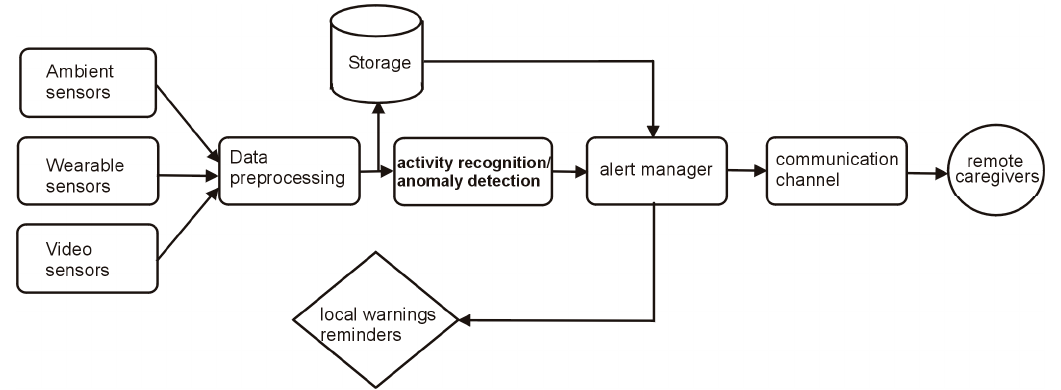
Figure 2. A general structure of a typical AAL system.